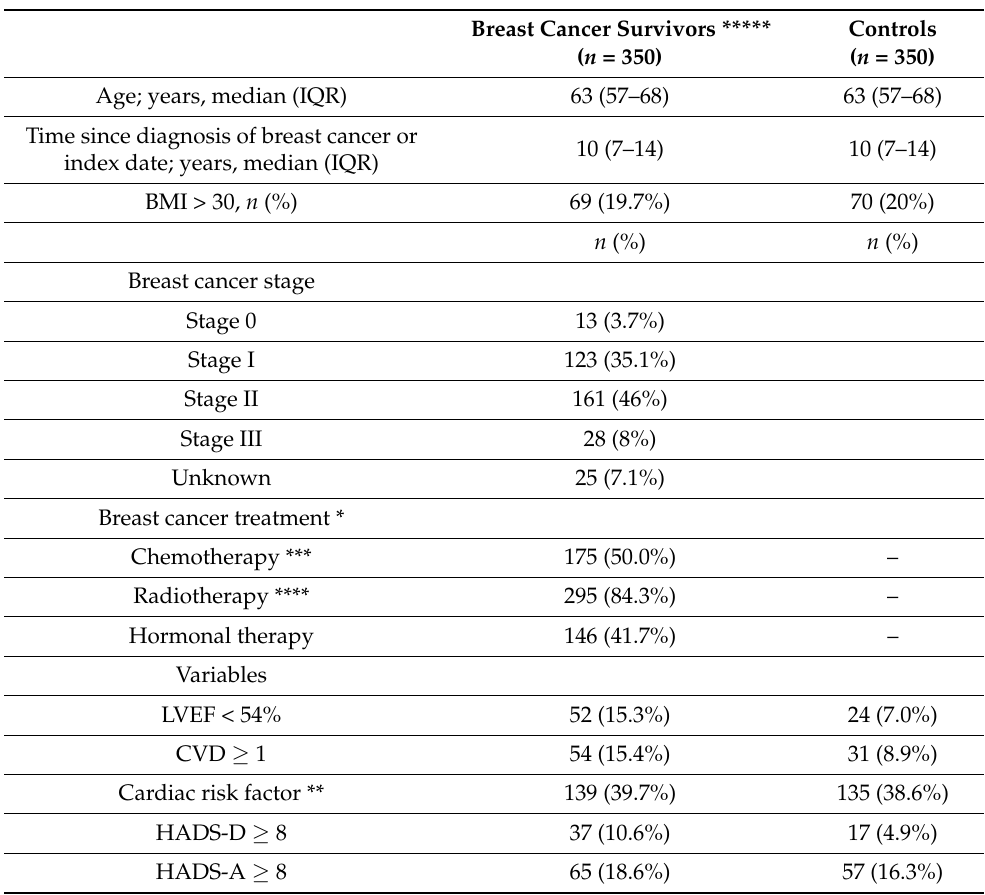
Table 1. Characteristics of breast cancer survivors and a reference population at the time of assess- ment